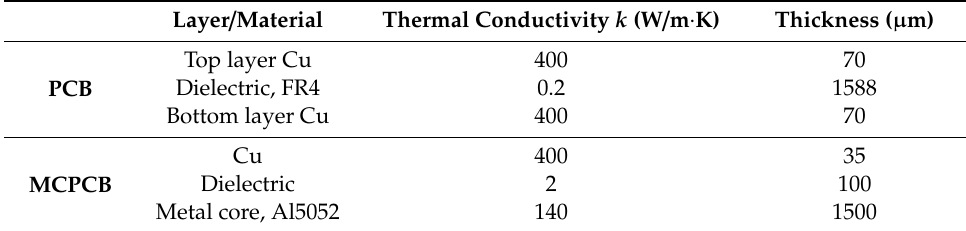
Table 4. Exemplary comparison of layers and their parameters in the printed circuit: (a) PCB and (b) MCPCB [46].